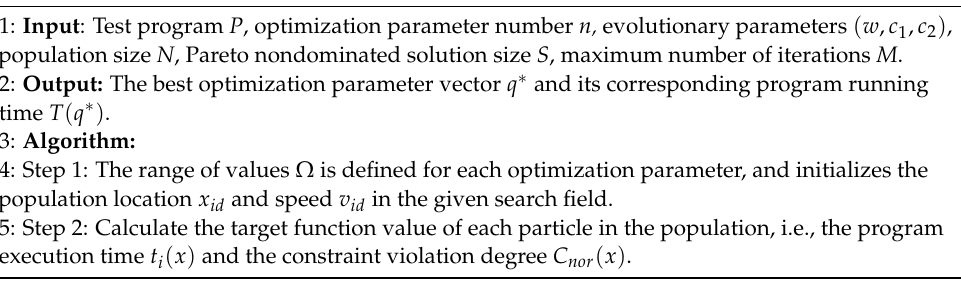
Algorithm 2 Optimization parameter selection algorithm based on